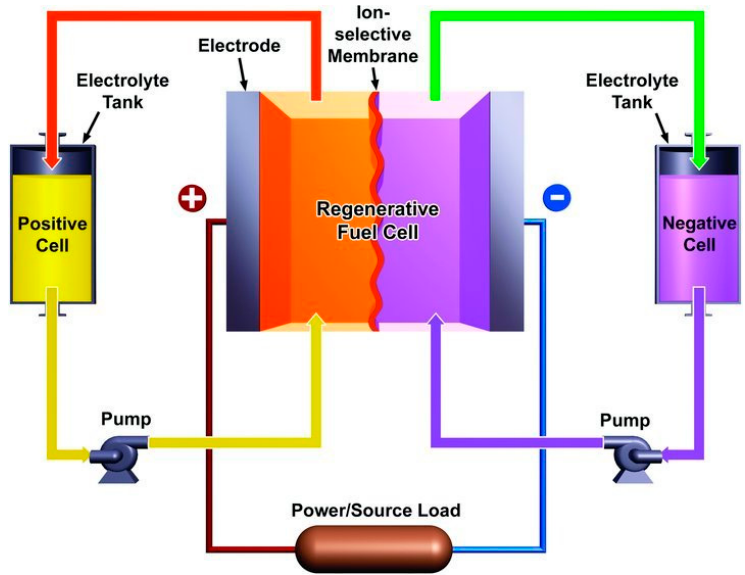
Figure 10. Schematic representation of a redox flow battery [114].